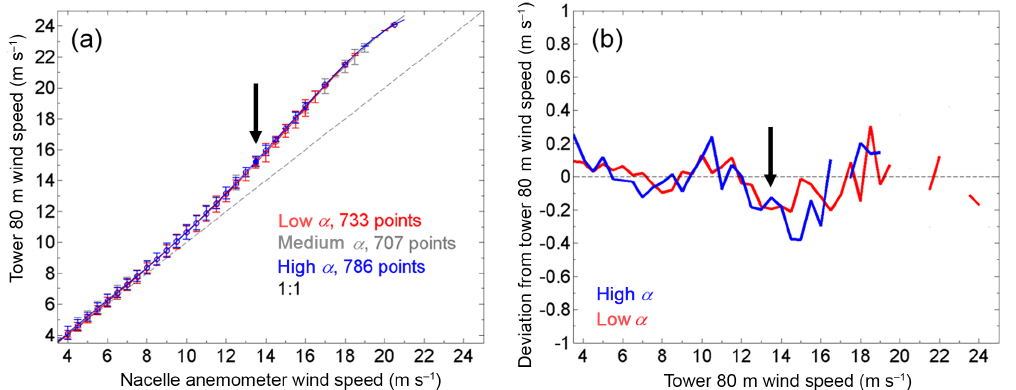
Figure 8. (a) Tower 80m NTFs calculated using fifth-order polynomial fits with stability regimes based on α . Error bars represent ± σ of the data within the same bins as the bins with which the NTFs are calculated. Statistically distinct differences within each wind speed bin between the stability classes are determined by the Wilcoxon rank sum test with a 1% significance level and denoted by closed circles. Black arrows point towards statistically distinct bins. The figures include data filtered for tower 80m wind speeds between 3.5 and 25.0ms − 1 , 87m wind directions between 235 and 315 ◦ , and for normal turbine operation. (b) Average deviation in NTF-corrected nacelle-mounted anemometer wind speed from tower 80m wind speed is shown during stable conditions (blue) and during unstable conditions (red) versus tower 80m wind speed with stability regimes based on α . The dashed line indicates a 0ms − 1 change. Table 4. Coefficients for fifth-order polynomial NTFs for stability metrics. R B Regime